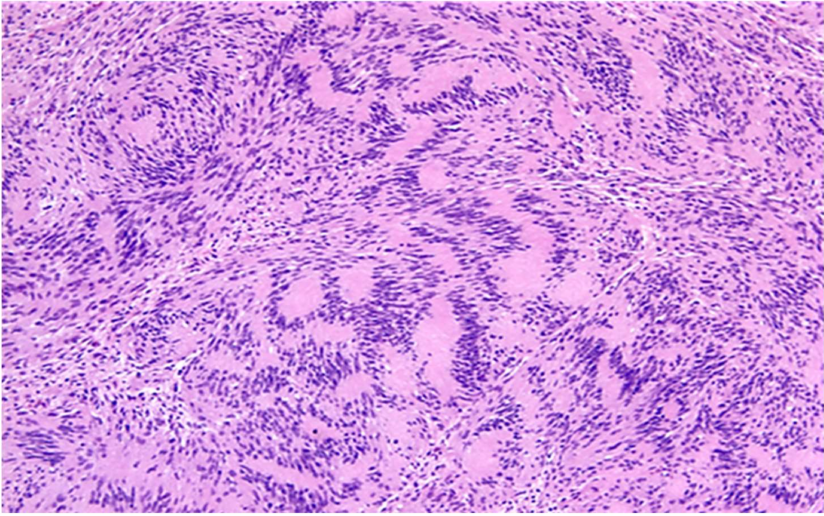
Figure 13. Classic schwannoma (Antoni A area). The diagnostic clue is the presence of numerous Verocay